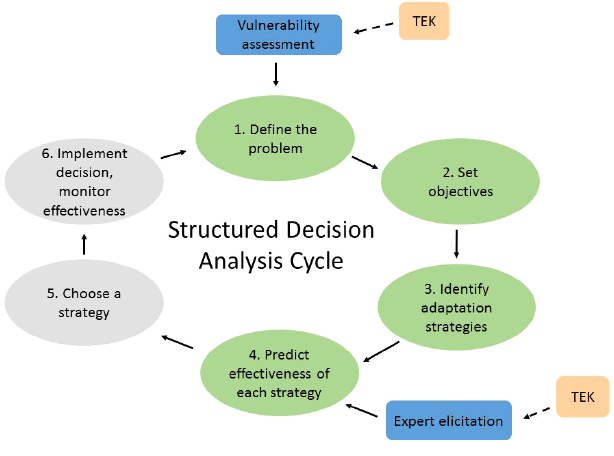
Fig. 1 . Steps in the structured decision analysis cycle, which we used to address climate change adaptation (Ohlson et al. 2005, Ogden and Innes 2009, Gregory et al. 2012). Steps 1 through 4 were addressed during our workshops; the remaining two steps were left to decision makers in the